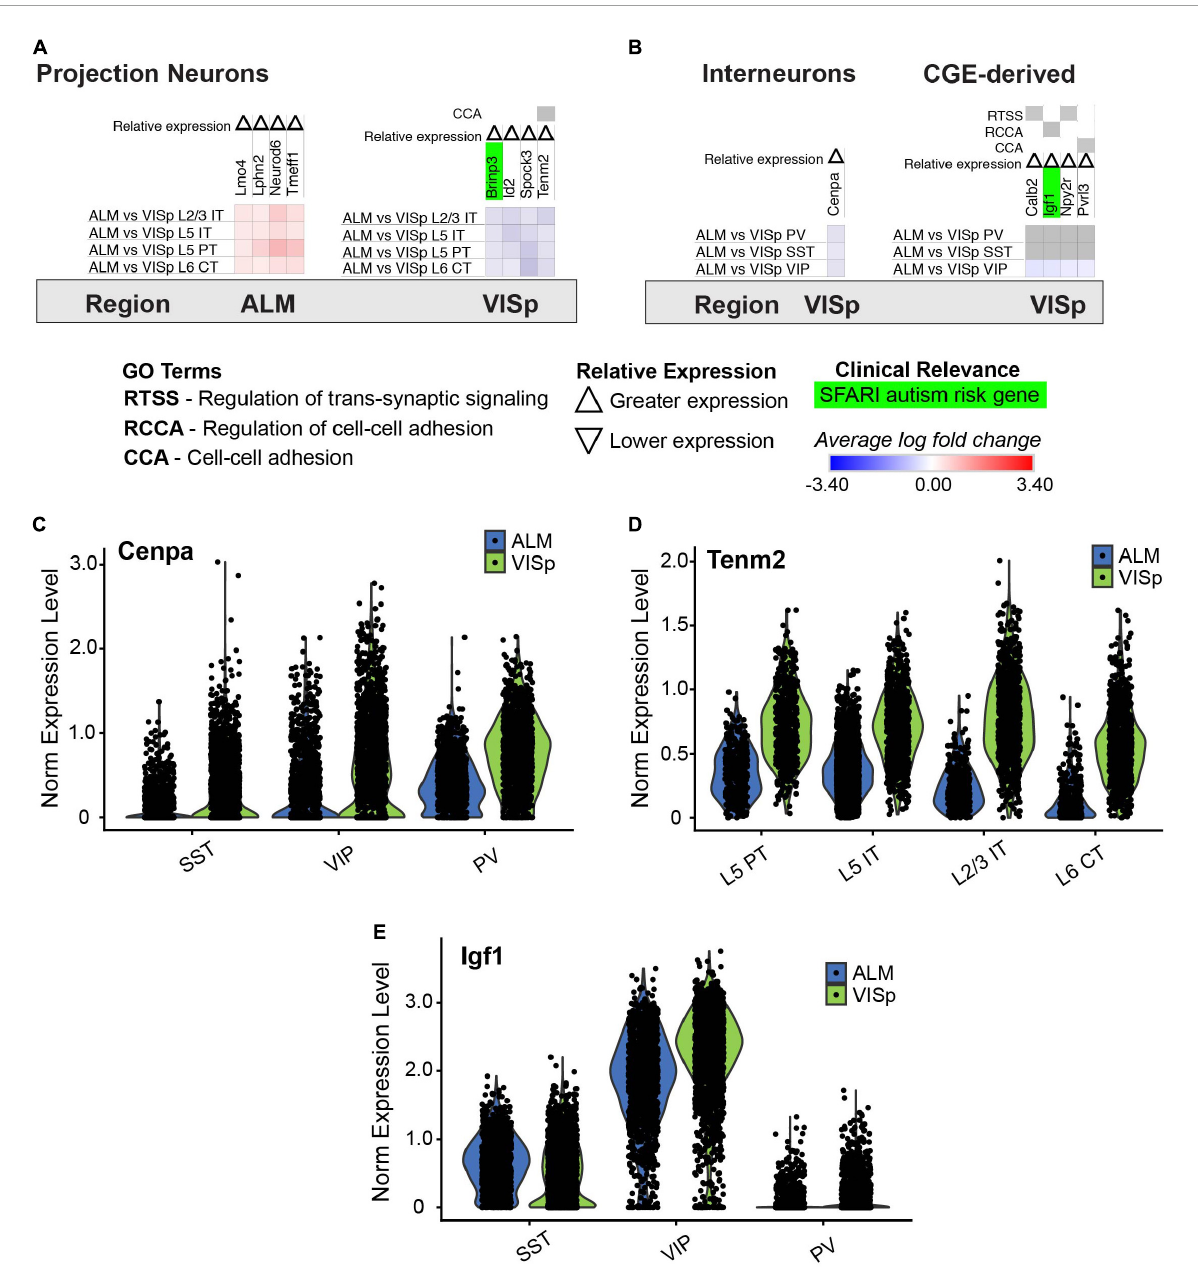
FIGURE10 Genes that have biased expression to ALM or VISp for all excitatory or inhibitory neuronal classes. Each row (e.g., ALM vs. VISp L2/3 IT) presents the results of differential expression tests for a neuronal class between cortical regions. Differential expression results are always relative to the first cortical region in a comparison (e.g., ALM in ‘ALM vs. VISp L2/3 IT’). Gray indicates no significance in differential expression. Shades of red and blue indicate the log fold change of average expression for tests that were statistically significant. Up and down arrows denote whether expression was higher or lower relative to the other cortical region. (A) Genes with biased expression between ALM or VISp for excitatory projection neuron classes. Note that only 1 gene, tenm2 , is circuit-related. (B) Genes with biased expression between ALM or VISp for inhibitory interneuron classes. ( Left ) Only 1 gene, cenpa , had biased expression among all classes. ( Right ) Only 4 circuit-related genes demonstrated biases in expression when comparing VIP to PV/SST classes. (C) Violin plots of cenpa single-cell expression for inhibitory interneuron classes in ALM and VISp. (D) Violin plots of tenm2 single-cell expression for excitatory neuronal classes in ALM and VISp. (E) Violin plots of igf1 single-cell expression for inhibitory interneuron classes in ALM and